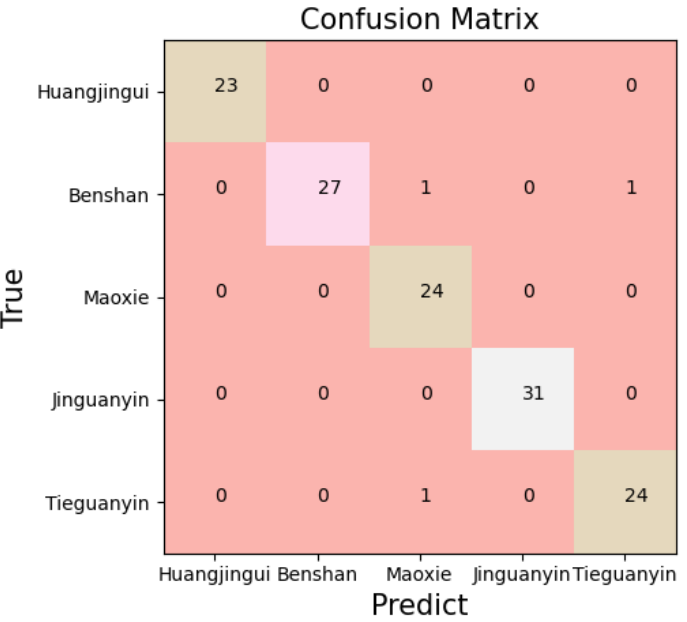
Figure 12. Confusion matrix of MSC-RF-RFE-SVM (The diagonal number is the number of correctly classified tea varieties) .